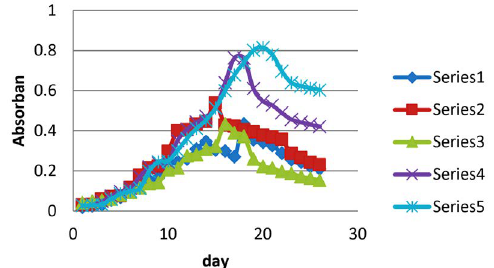
Fig. 2. The graphic of the MA1 microalgae growth curve using commercial fertilizers with concentrations of P1, P2, P3, P4 and